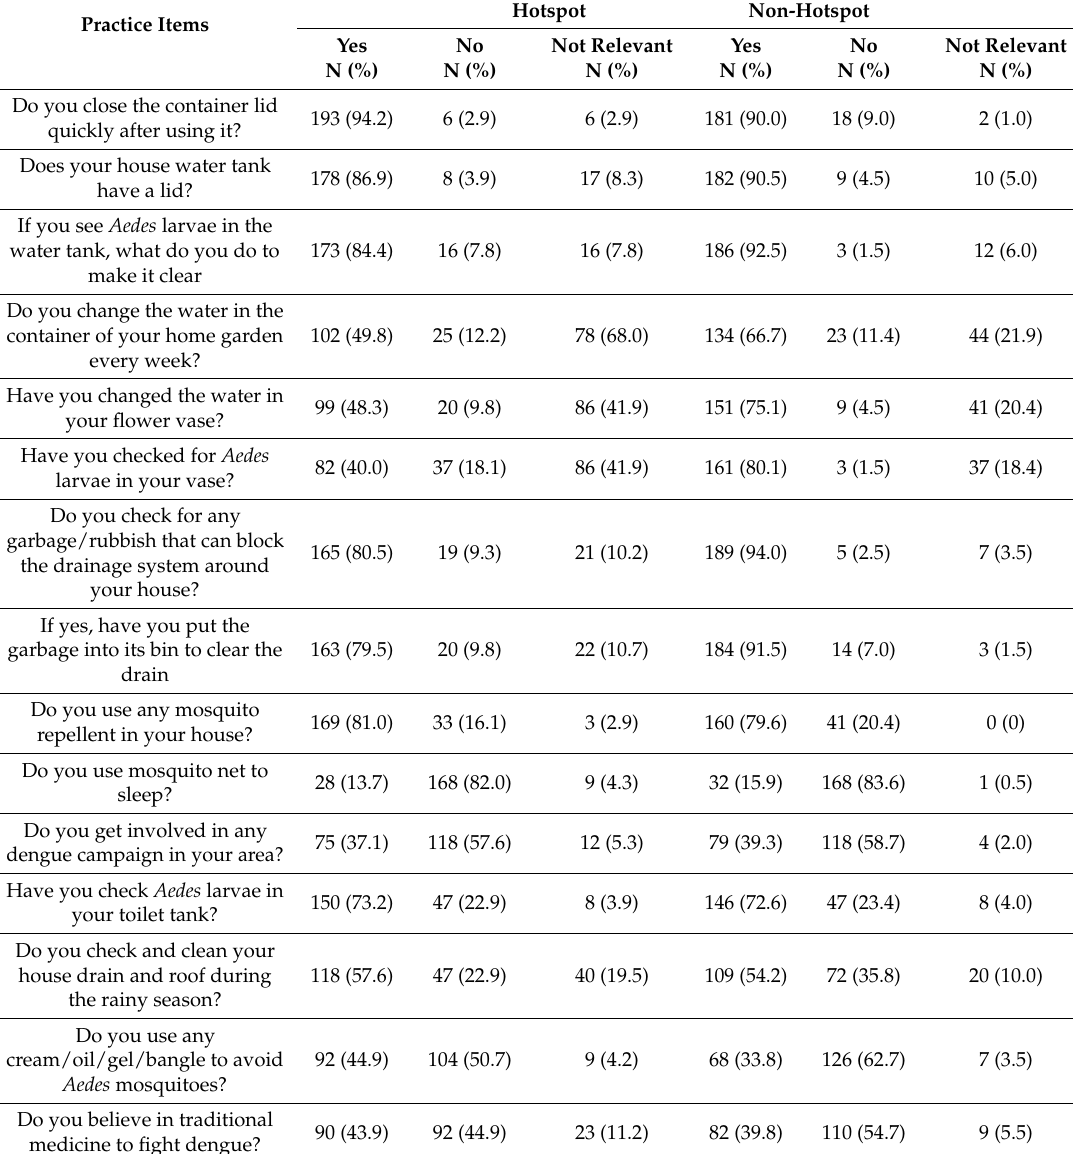
Table 4. Practice of Respondents’ Towards Dengue Vector